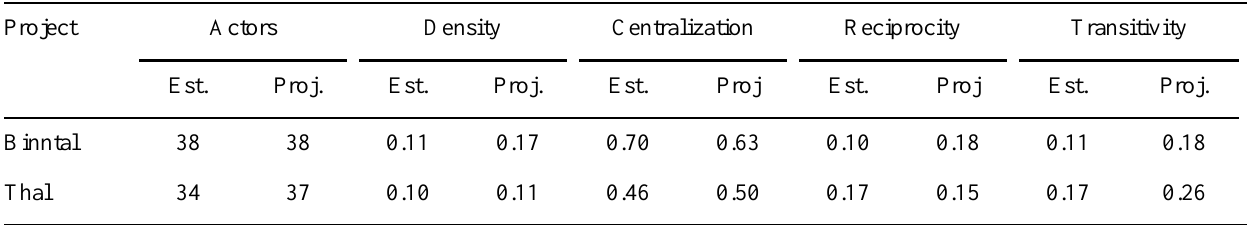
Table 5. Network closure. Project Actors Density